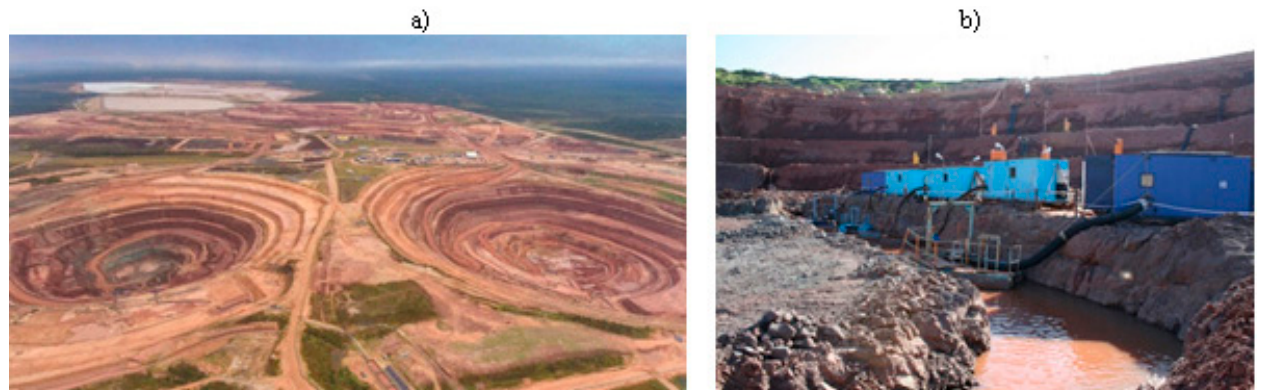
Figure 2. ( a ) Quarries on Arkhangelskaya and Karpinsky kimberlite pipes of Lomonosov diamond deposit and ( b ) quarry drainage at Karpinsky pipe open pit.